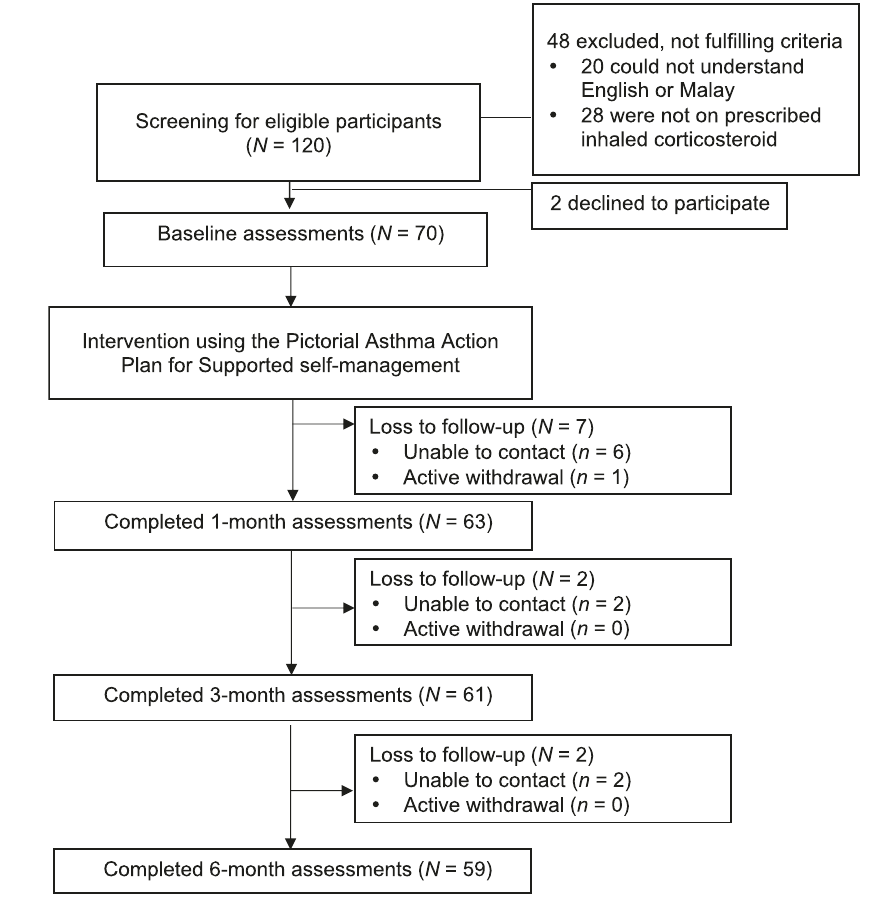
Fig. 1 Flow of study